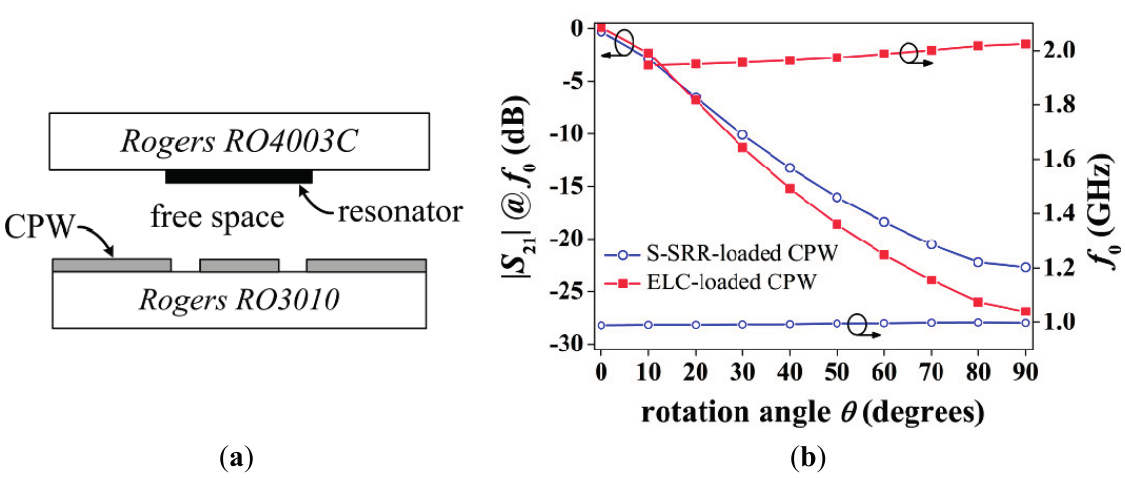
Figure 13. ( a ) Sensor layer cross-section; and ( b ) simulated transfer function for the topologies in Figure 11. The parameters of Rogers RO4003C are: thickness h = 0.8128 mm, relative permittivity ε r = 3.55, and loss tangent tan δ =